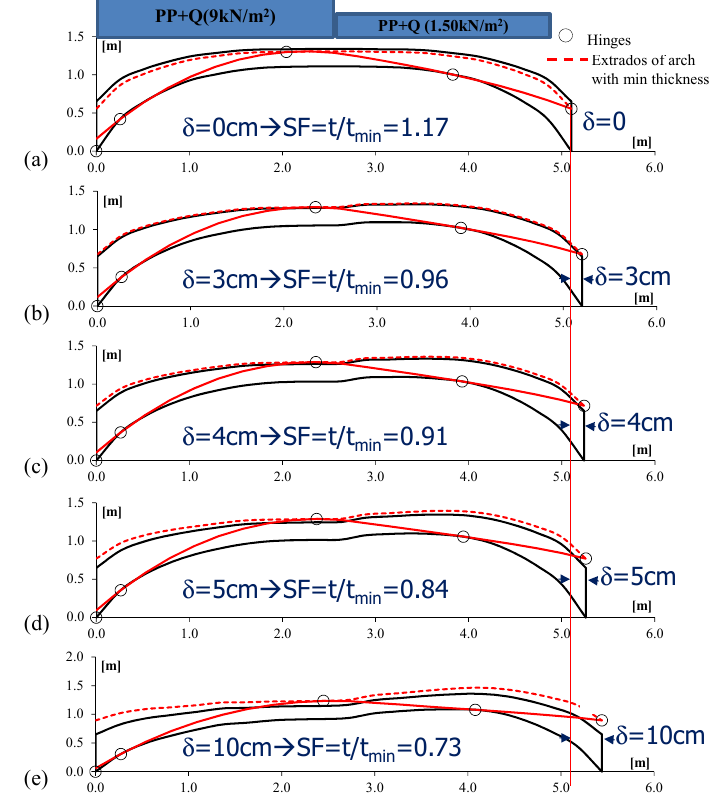
Figure 9. Evolution of geometrical safety factor SF for the arch in y-direction for different values of the horizontal settlement δ imposed at the right constraint of the arch: ( a ) δ = 0; ( b ) δ = 3 cm; ( c ) δ = 4 cm; ( d ) δ = 5 cm; and ( e ) δ = 10 cm.